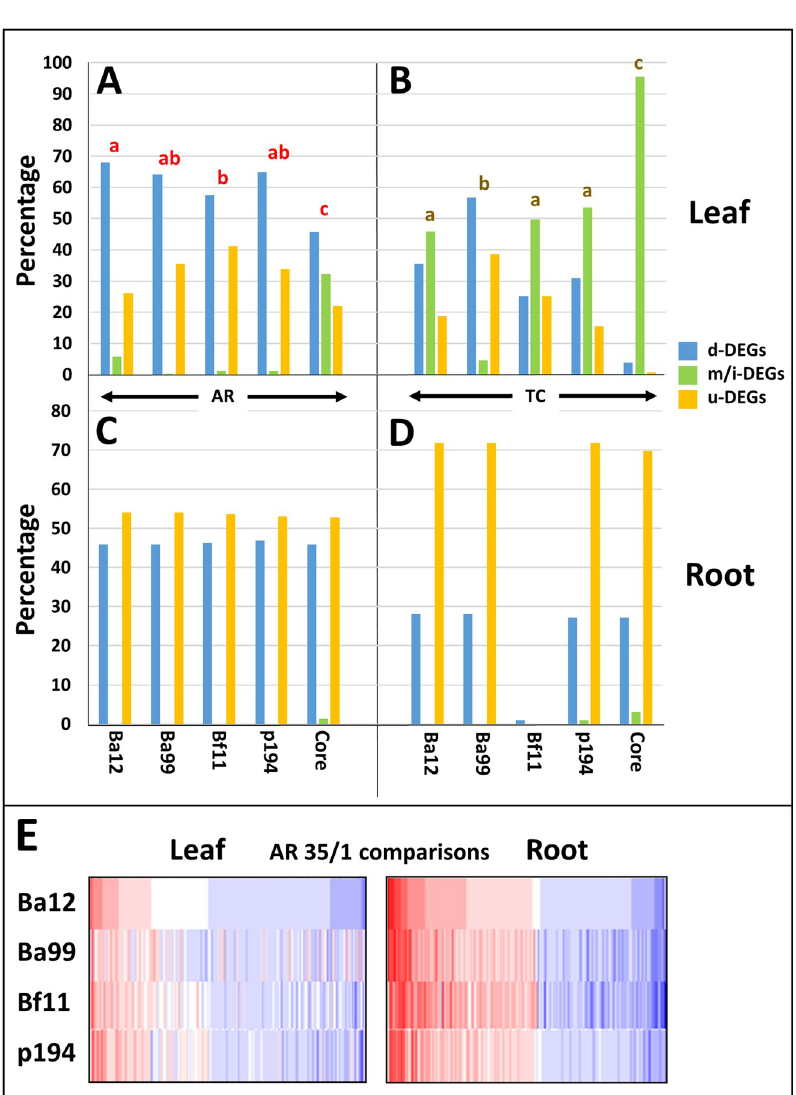
Fig 3. The patterns of expression of core differentially expressed genes according to genotype and comparison. A —D. The patterns of up (u-), down (d-) mixed (m-) or inconsistent (i-) differentially expressed genes (DEGs) in the leaf and root for core DEGs and the same DEGs taken from the Trend data sets. m-DEGs refers to the core set and i- DEGs refers to the trend sets. Comparisons were made between genotypes within: A. leaf against reference (AR) core DEGs: B. leaf time course (TC) core DEGs; C. root AR core DEGs; D. root TC core DEGs. The relative proportions of the 3 classes were compared across genotypes and the core set in leaves and root using χ 2 . Where the initial χ 2 was significant (p < 0.05), post hoc pairwise genotype and core χ 2 comparisons which were significantly different from each other, using a 5% FDR to control for multiple testing, do not share any of the same red (AR) or brown (TC) letters above the categories. No significant differences were found for the root. E. Heat maps showing the patterns of up- and down-regulation of the core DEG set for leaves and roots at the 35% vs 1% (35/1) estimated growing medium water content comparison. Both leaf and root sets were ordered from maximum to minimum in terms of log fold change (LFC; dark red to dark blue) according to the Ba12 LFC values. It can be seen that patterns of up- and down-regulation are more strongly conserved in the roots as compared to the